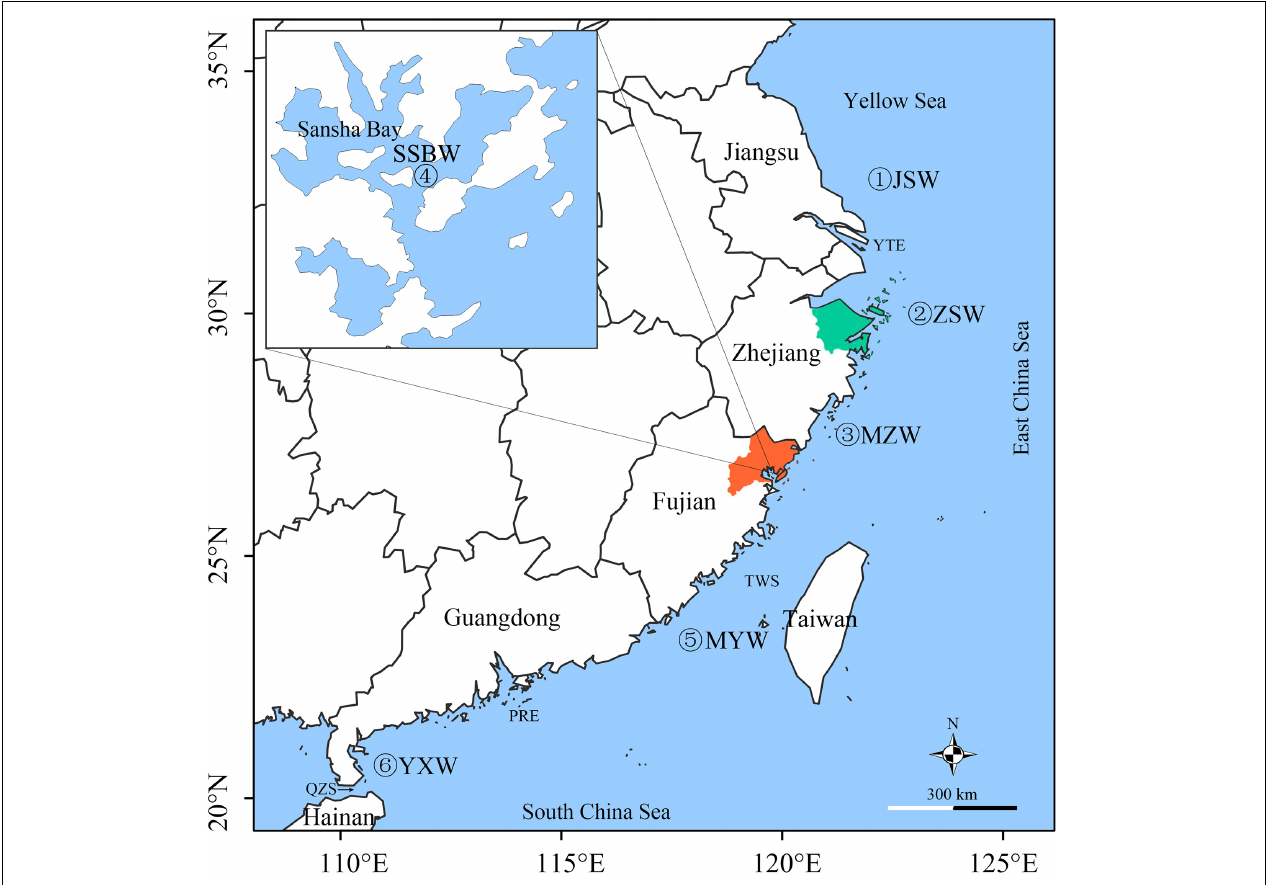
FIGURE 1 | Sampling locations of large yellow croaker populations. JSW, Jiangsu population; ZSW, Zhoushan population; MZW, Minzhe population; SSBW, Sansha Bay population; MYW, Minyue population; and YXW, Yuexi population are wild populations caught in the corresponding seas. The orange area is Ningde City, where most of the FJC fry were produced, and the green areas are Ningbo City and Zhoushan Island, where most of the ZJC fry were produced. The inset map shows Sansha Bay, which is historically the largest spawning and nursery area of large yellow croaker and has been one of the major hatchery release grounds since 2000. TWS, Taiwan Strait; PRE, Pearl River Estuary; QZS, Qiongzhou Strait; YTE, Yangtze